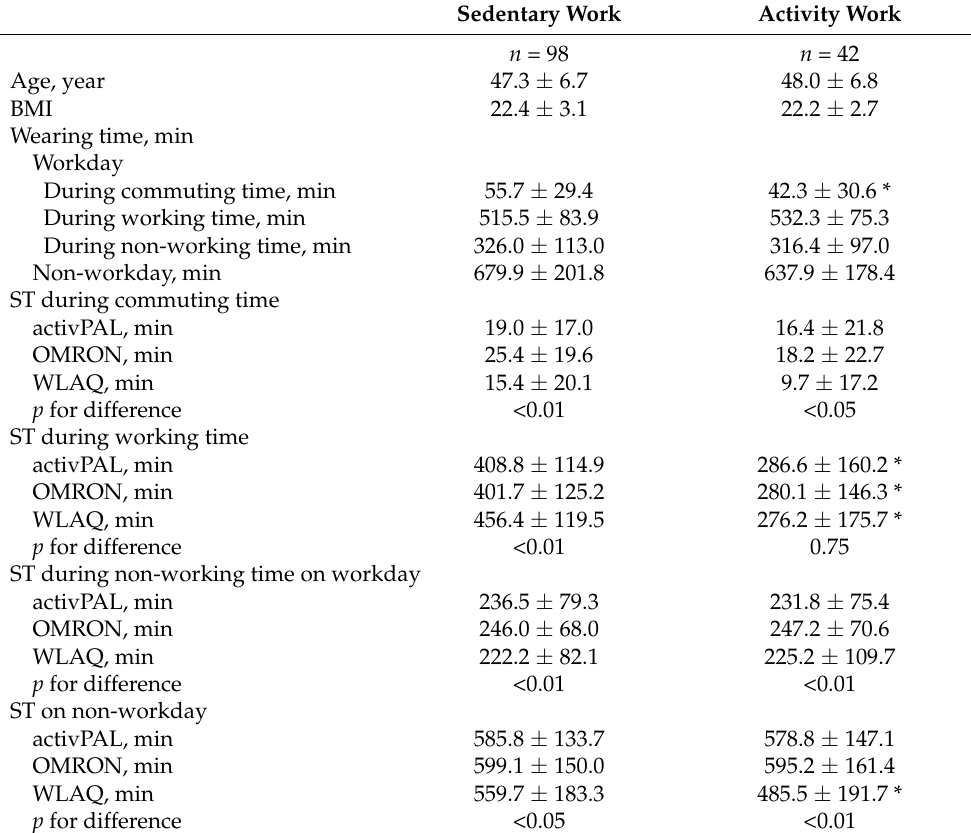
Table 3. Characteristics of participants and comparison with domain-specific sitting time measured by three measurement methods between the